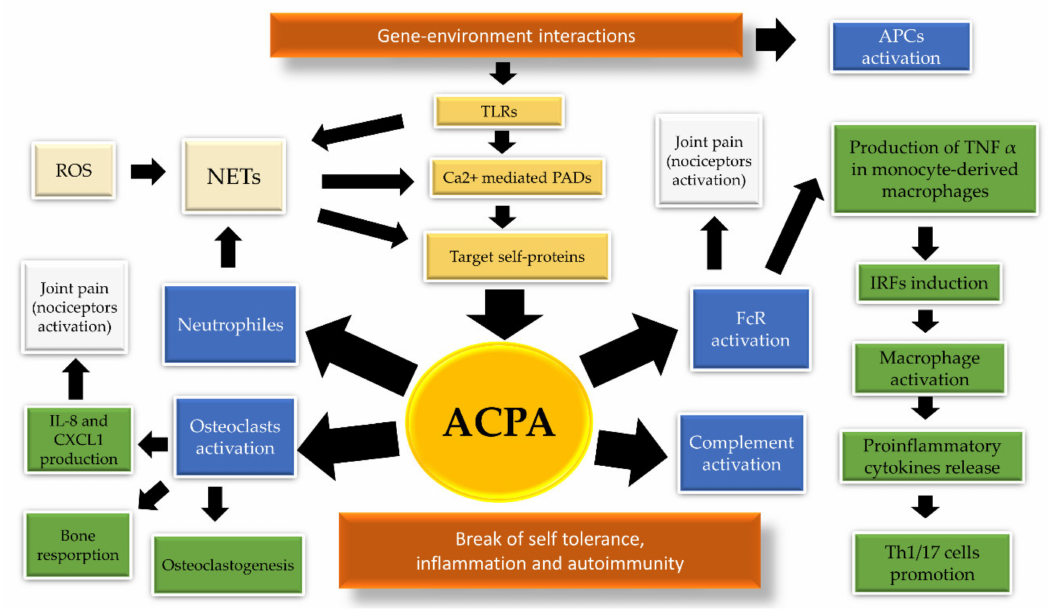
Figure 2. Various biological e ff ects of anti-citrullinated protein antibodies (ACPA). The production of ACPA reflects break of immune tolerance and is dependent on the occurrence of both genetic, epigenetic and environmental factors. Genetic factors are: shared epitopes (SEs), protein tyrosine phosphatase non-receptor type 22 (PTPN22), α 1-antitrypsin, type I interferons. Epigenetic modifications are: DNA methylation, histone acetylation and deacetylation, miRNA expression. Environmental factors include: noxious agents, influence of pathogens such as Porphyromonas gingivalis, Aggregatibacter actinomycetemcomitans (Aa) and Epstein–Barr virus (EBV). Interaction between genetic